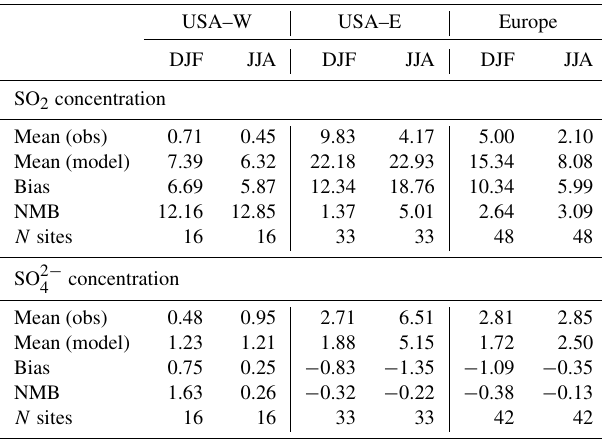
Table 5. Statistics for seasonal mean surface SO 2 and SO 2 centrations (µgm − 3 ) at USA–W, USA–E, and Europe. The mean seasonal values are averaged over the period